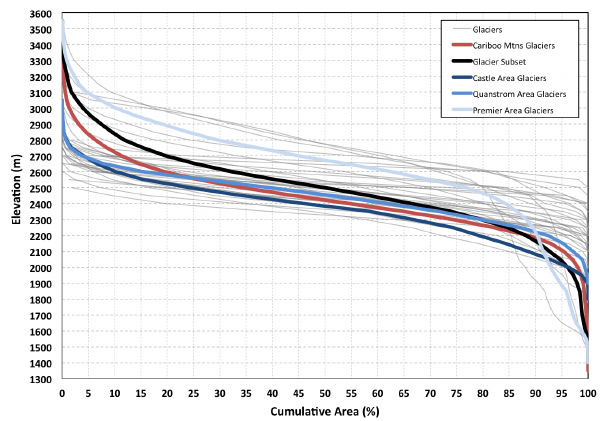
Figure 5. Hypsometries for our subset of glaciers (gray); aver- age subset hypsometry (black); all Cariboo Mountains glaciers (red); and the Castle, Quanstrom, and Premier subregions (darker to lighter blue, respectively).